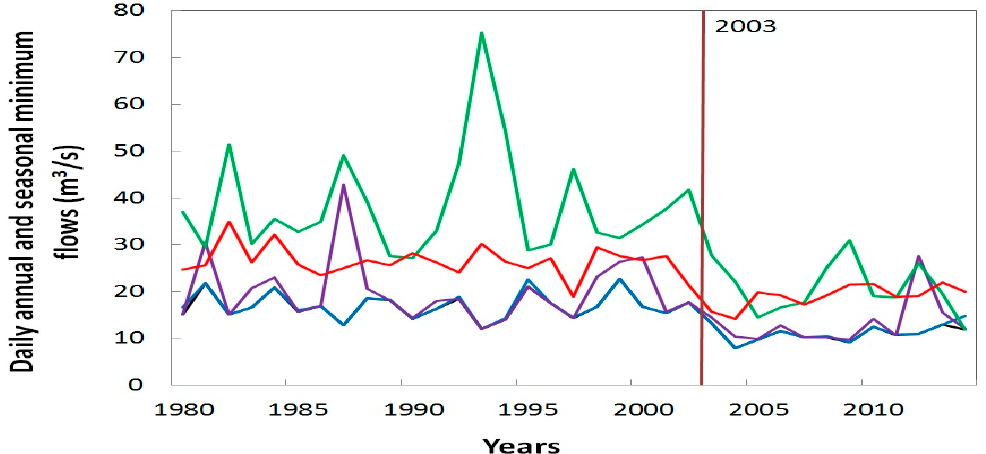
Figure 2. Temporal variability of annual and seasonal daily minimum flows before and after construction of the diversion dam in 2003 (vertical line). This vertical line also represents the timing of the shift in mean values of the series. Annual = black curve; winter: blue curve; spring = purple curve; summer = green curve; fall = red curve.